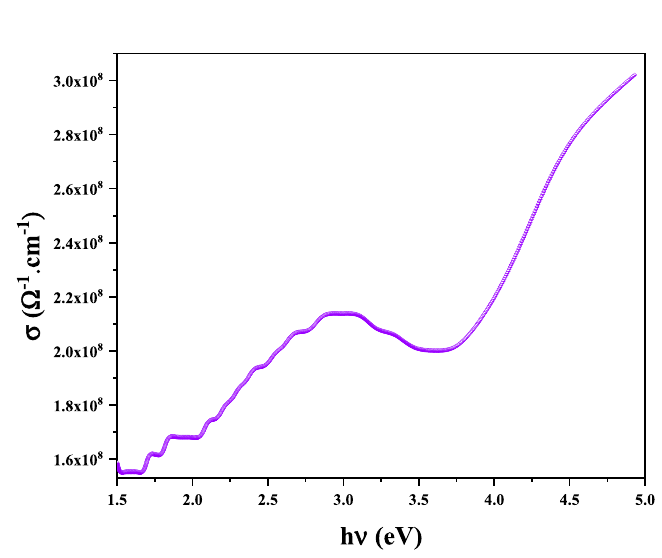
Figure 11. The relation between optical conductivity and energy of AgO/Ag